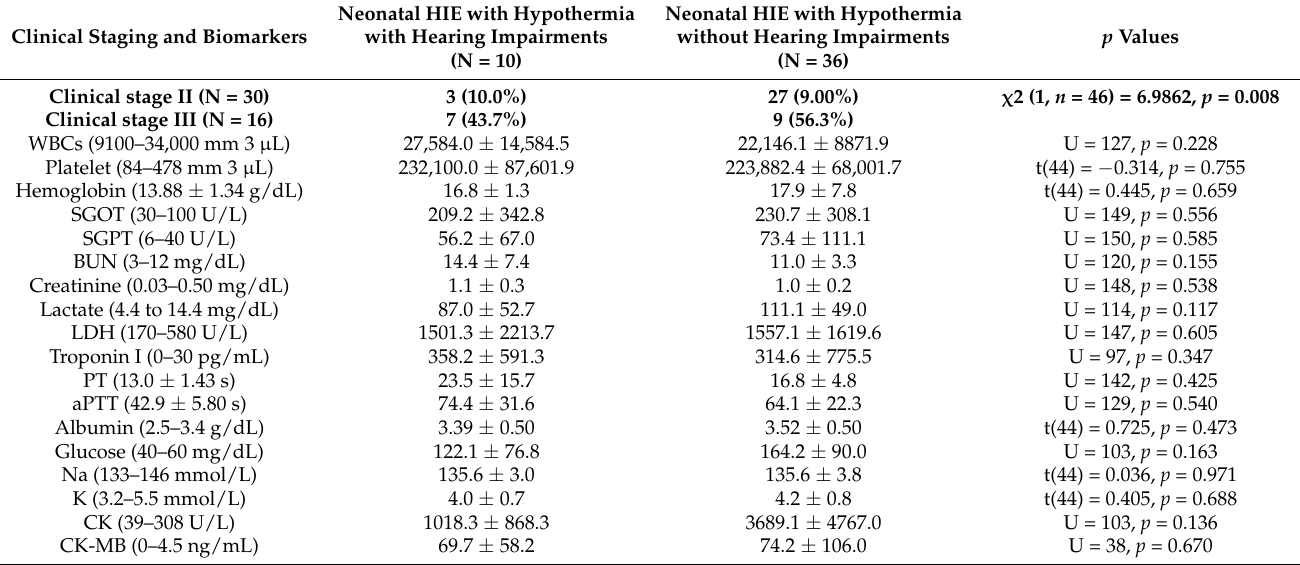
Table 3. Biomarkers in patients with neonatal HIE with and without HI who were receiving hypothermia therapy. Clinical Staging and Biomarkers